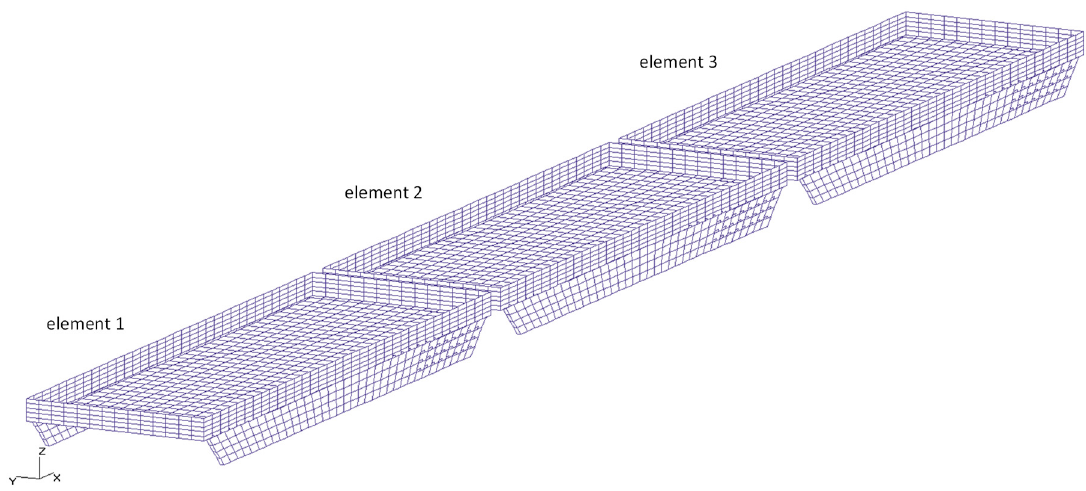
Figure 3. The panel model of the breakwaters array.